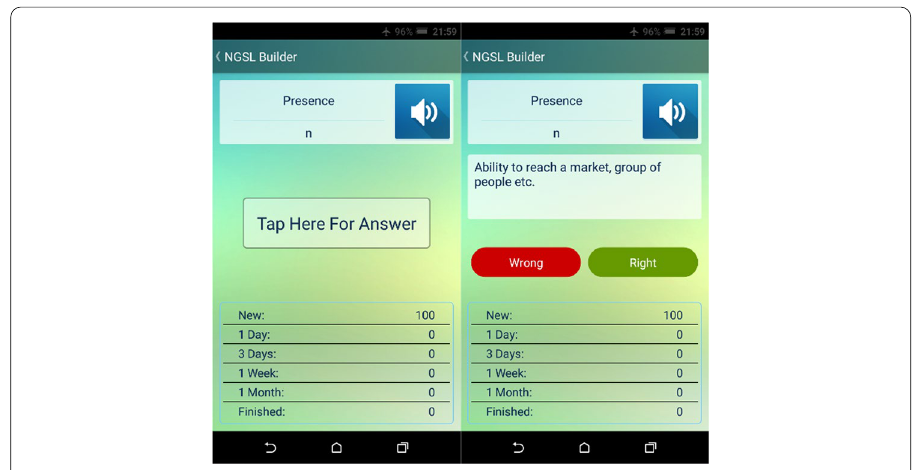
Fig. 2 sample flashcard features in NGSL